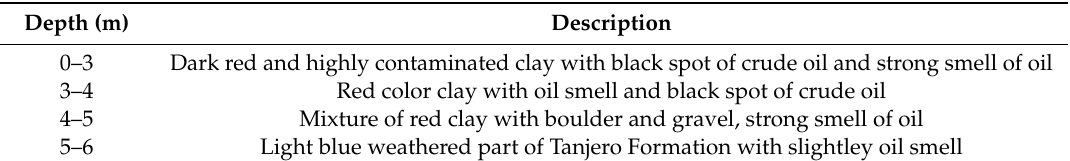
Figure 6. Location map of the water and soil sample collected in the study area. (1) Oil Refinery. (2 ) Chalaka Petrol Stations. (3) Aqary Petrol Stations. Table 1. Soil profile Table 3. Soil Samples locations for tetraethyl lead analysis at Sulaymaniyah Oil R.D.